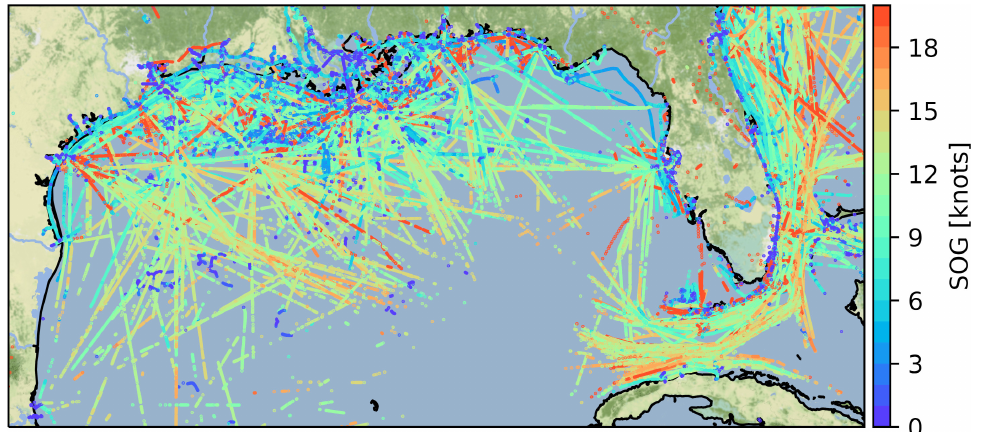
Figure 1. The usual shipping lanes and common patterns are directly accessible in the visualization of AIS messages, exemplarily shown for the Gulf of Mexico (first four days of June 2020). The historic AIS data is made publicly available by the NOAA Office for Costal Management (AIS data was obtained by https://coast.noaa.gov/htdata/CMSP/AISDataHandler/2020/index.html, accessed on 3 December 2021. Note that the central area with sparse AIS data might be explainable by the range of AIS transceivers and the providers’ reception capabilities).